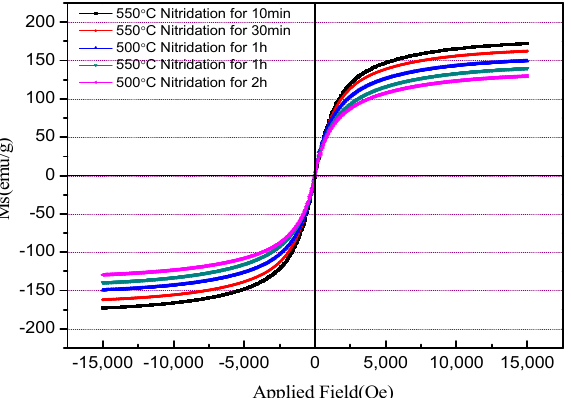
Figure 7. Magnetic hysteresis loop of the Fe(Si) nitride powder at room temperature.